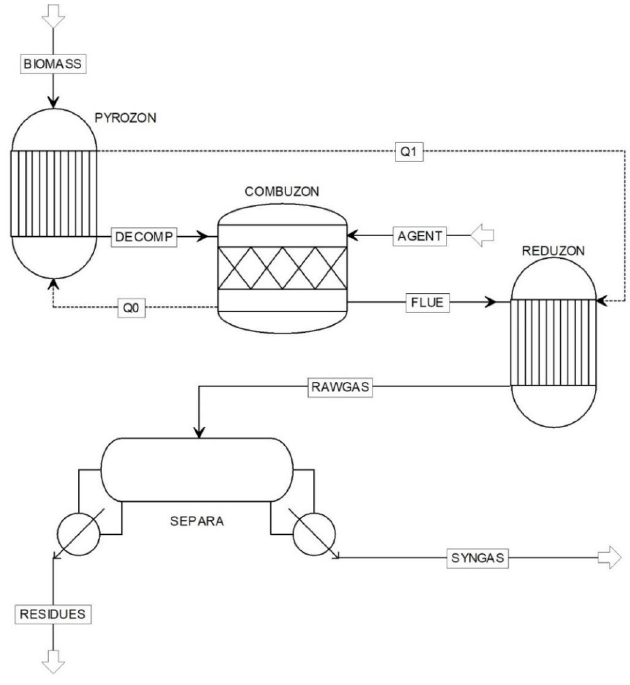
Figure 2. Downdraft Gasifier Model.